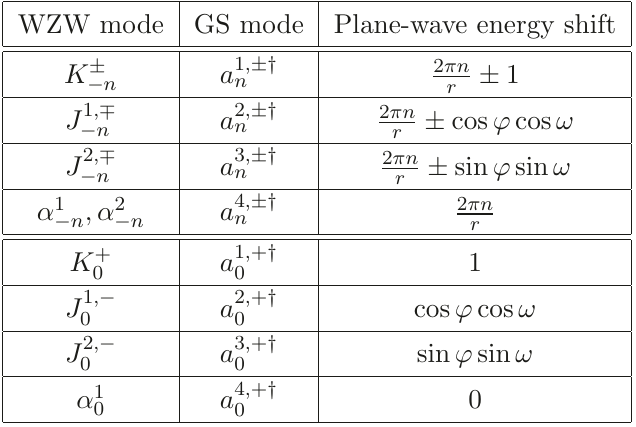
Table 1 . Identification of the bosonic modes in the holomorphic sector. The modes of the left- moving currents with n > 0 are related to GS oscillators with n >